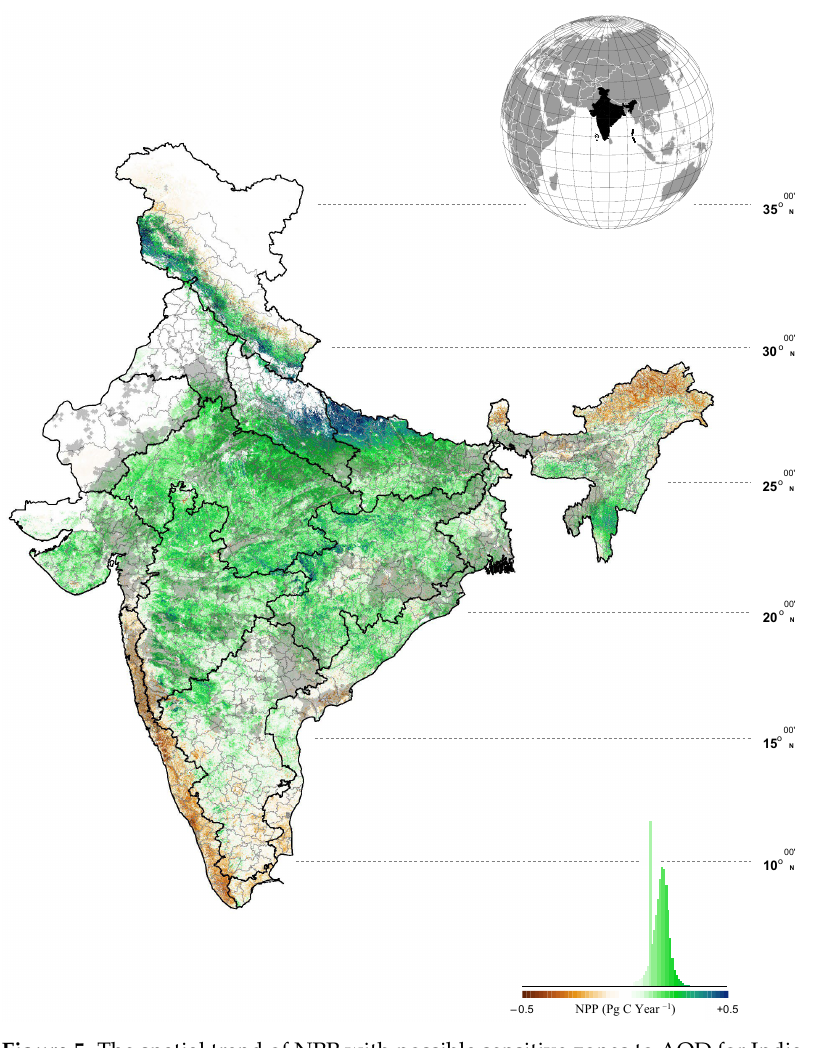
Figure 5. The spatial trend of NPP with possible sensitive zones to AOD for India. Sensitive areas of NPP to AOD are highlighted with black shading ( p < 0.05). The histogram represents the distribution of NPP pixels for the overall trend.